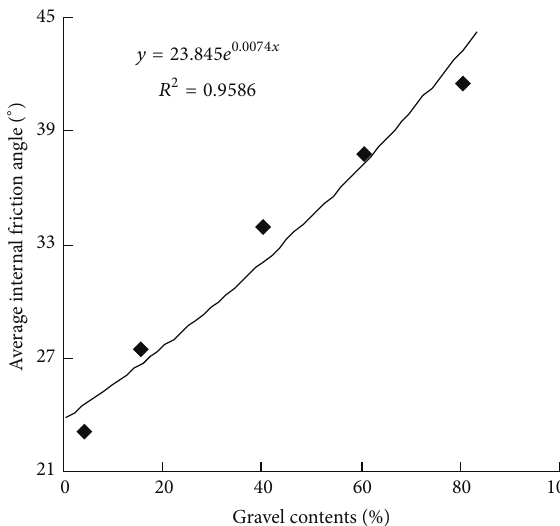
Figure 11: Relationship between 𝜑 and gravel contents of